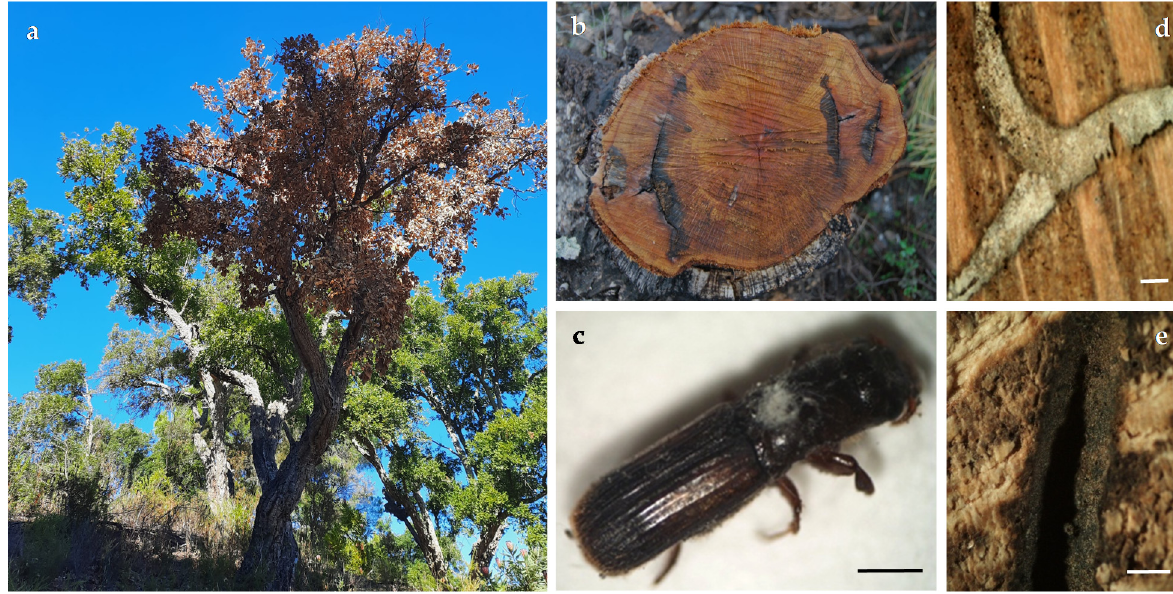
Figure 1. ( a ) Cork oak affected by Platypus cylindrus and its ambrosia fungi; ( b ) cross section of the trunk with wood staining along the galleries; ( c ) emerged beetle with the ambrosial mycelium coming out of the mycangia; ( d ) transversal cut showing the gallery lined by a silky white mycelium, ( e ) older gallery (bars = 1 mm).